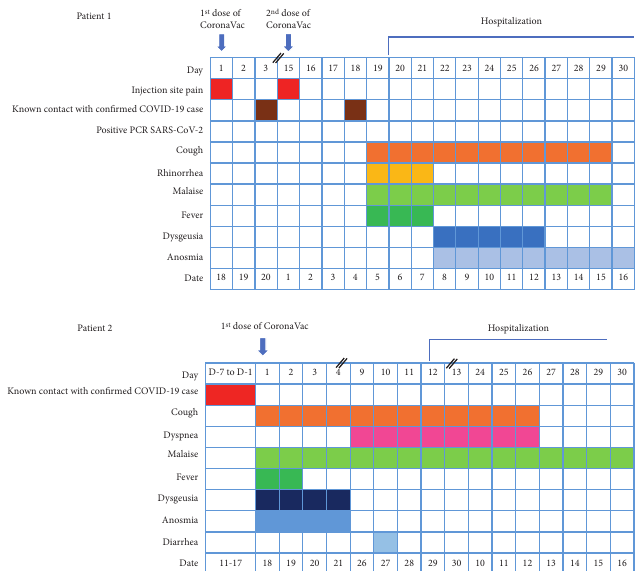
Figure 1: The history of vaccinations and development of symptoms in patient 1 after 1 dose of CoronaVac vaccine and in patient 2 after 2 doses of CoronaVac vaccine. In patient 1, two vaccination doses were completed 18 days before the first appearance of symptoms. In patient 2, the patient was vaccinated on the day the symptoms appeared. In both patients, exposure to confirmed COVID-19 cases occurred within 2 weeks prior to the presentation of symptoms.